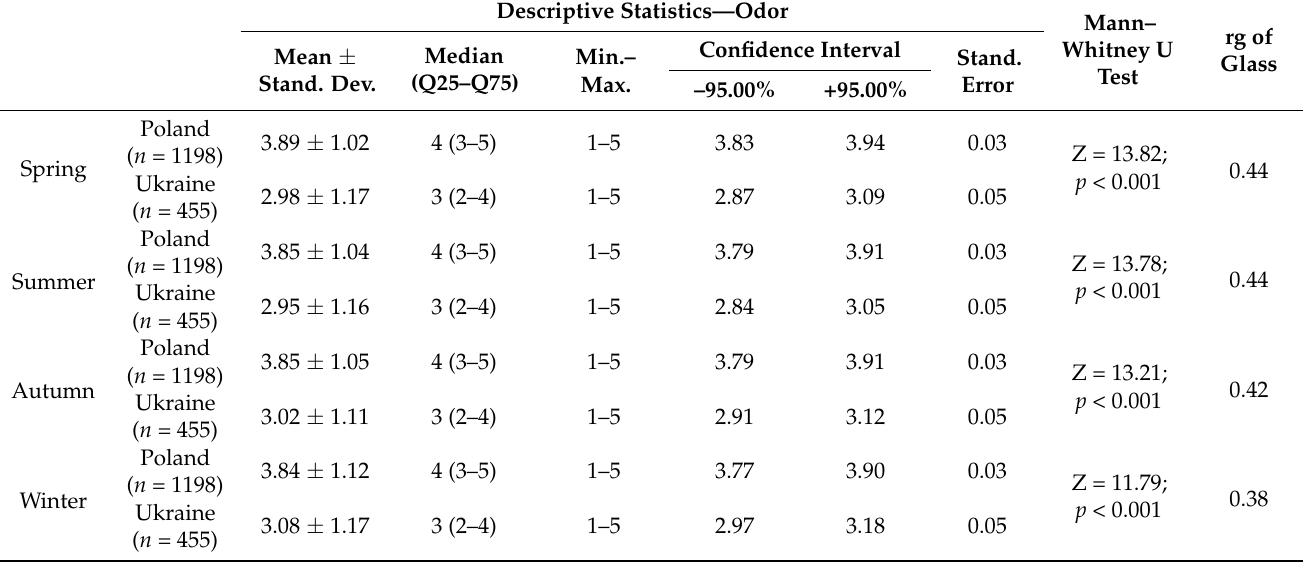
Table 9. Comparison of groups of respondents from Poland and Ukraine in terms of evaluation of tap water odor during individual periods of the